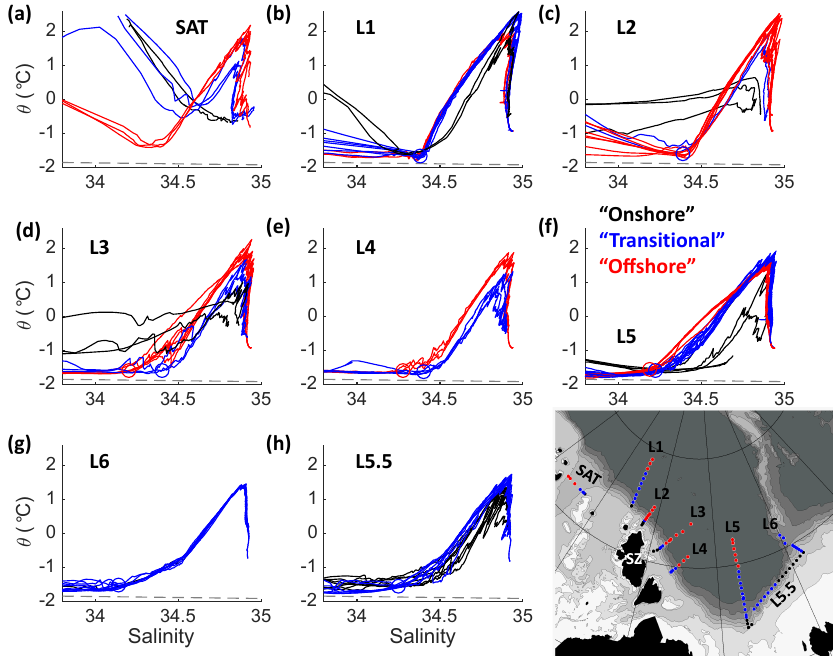
Figure 3. The panels exhibit θ – S diagrams for all data collected during the 2013 cruise. Data are divided among sub-panels according to transect (SAT, L1, L2, L3, L4, L5, L5.5, and L6) with the locations of each transect shown in the inset map. The θ – S data measured at each station are colored black (closest to shore or “onshore”), blue (“transitional” between onshore and offshore), or red (farthest “offshore”) according to its relative onshore vs. offshore position. Along the St. Anna Trough (SAT) section, the colors indicate the relative position of stations farthest west (red), central/east (blue), and farthest east/shallow (black) rather than onshore/offshore. The relative positions were defined differently along each transect according to fronts observed in θ – S characteristics as described in the text. Red and blue circles on these diagrams show the mean positions of LHW at the transitional and offshore stations along each transect, respectively. LHW positions along L1 and L2 did not significantly differ between transitional and offshore stations; therefore, only a single position is plotted. Note that all stations on the L6 transect were plotted in blue as there was little difference among stations indicative of a θ – S